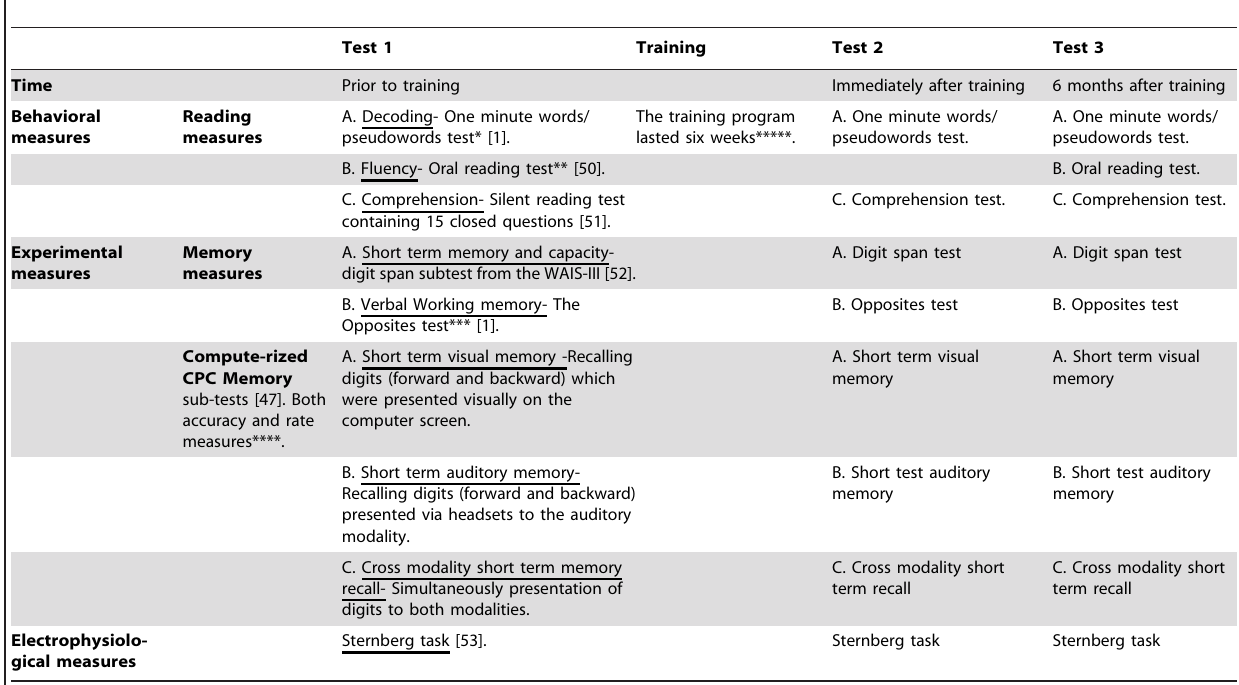
Table 1. Experimental procedure, and behavioral and experimental